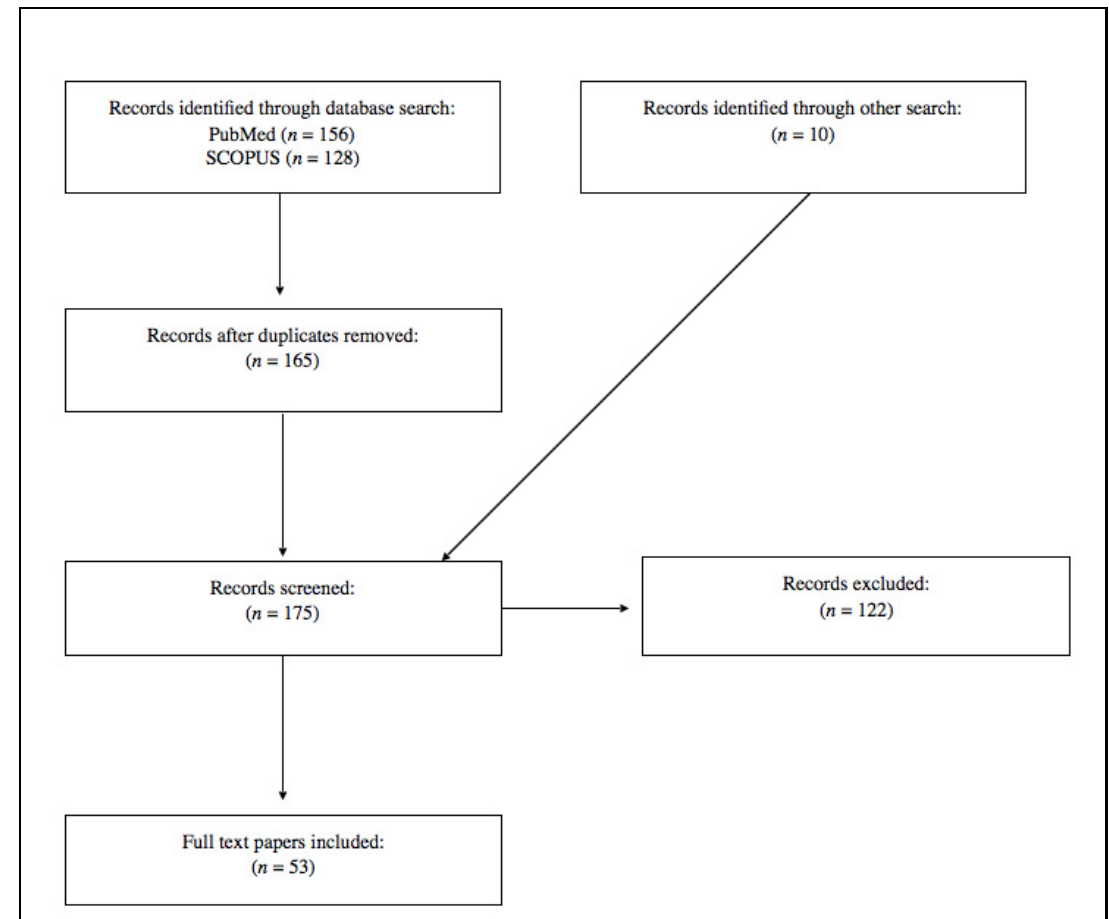
Figure 1. Flowchart depicting the choice of studies.